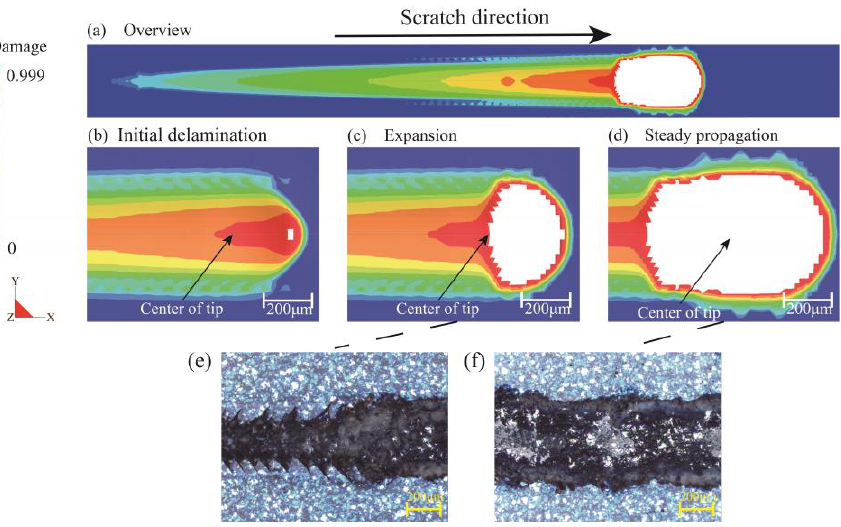
Figure 8. Top view demonstration of the delamination process. The damage variable evolution of the cohesive zone interface is presented. ( a ) Overview; ( b ) Initial delamination; ( c ) Expansion; ( d ) Steady propagation; ( e , f ) Experiment results.